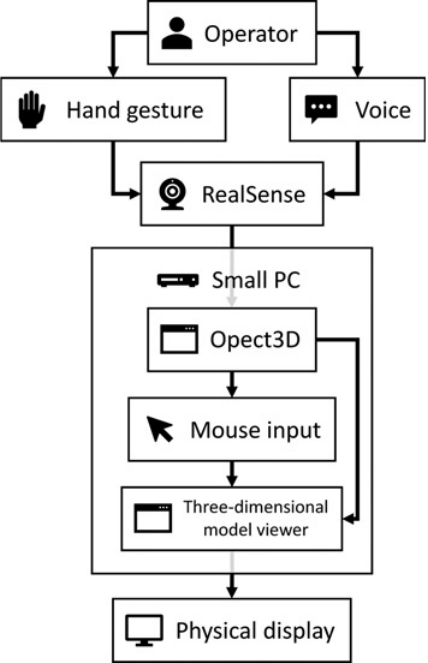
F i g ure 1 Flo w dia g ram of the Opect3D interface. Hand- g est u res and v oice commands are detected b y the RealSense camera and then fed into the Opect3D pro g ram in a small comp u ter. The Opect3D takes o v er mo u se f u nction to control the three-dimen- sional model v ie w er. Three-dimensional medical ima g es are g en- erated b y the model v ie w er on a ph y sical displa y , and the v ie w in g an g le of those can be adj u sted b y hand- g est u res and v oice com- mands thro ug h the